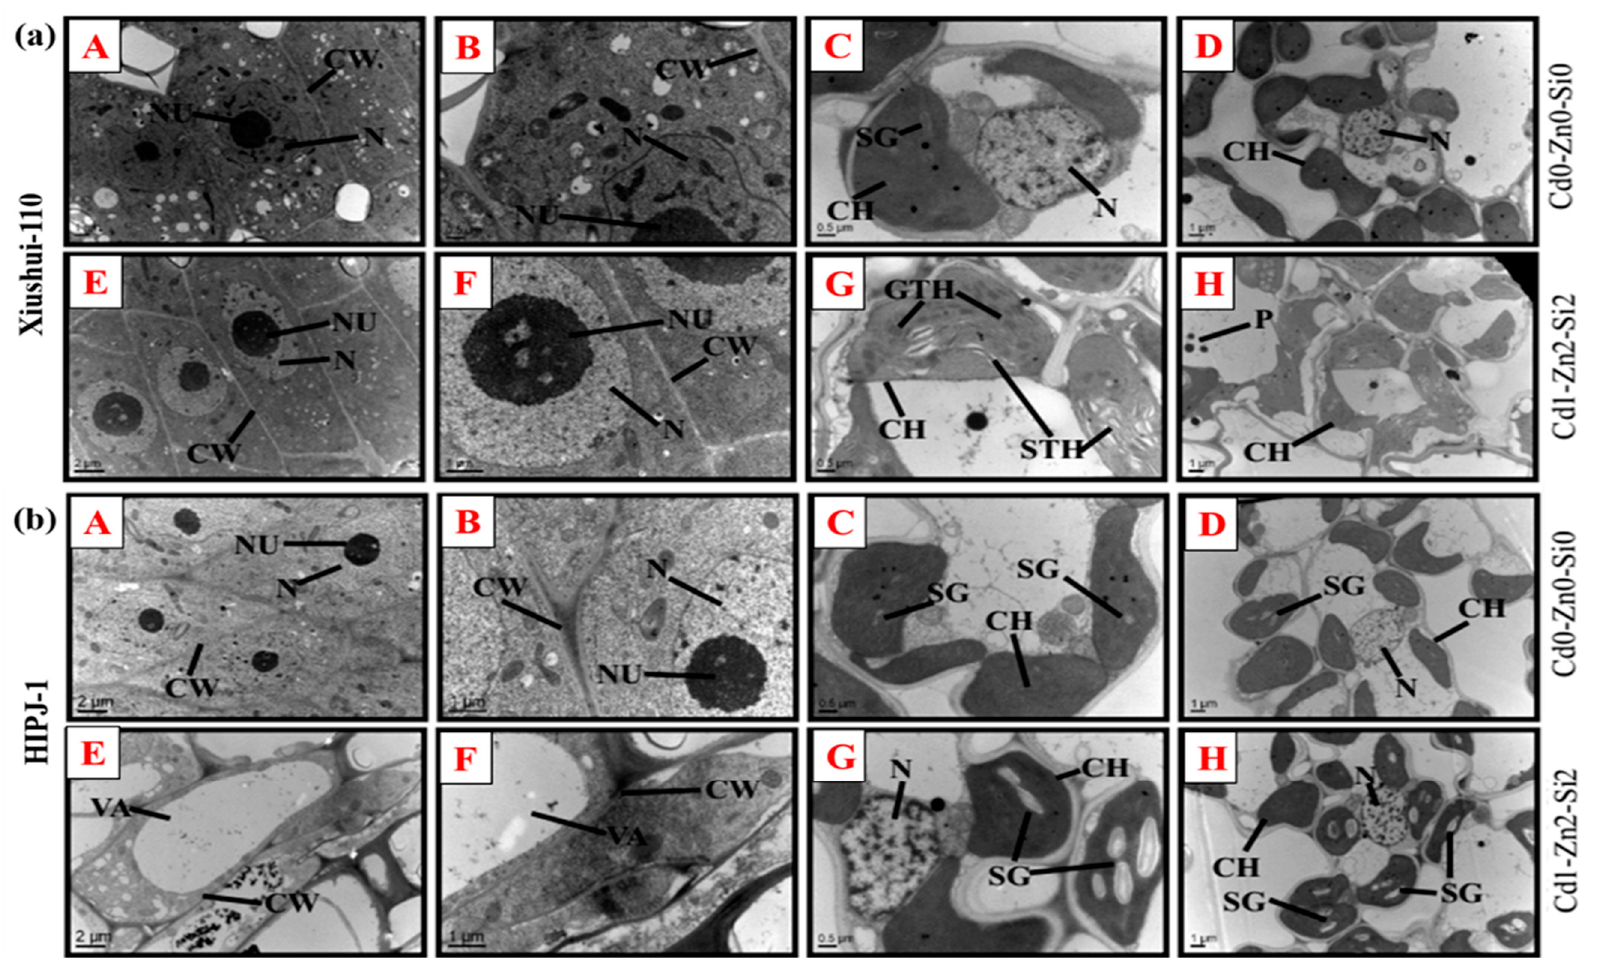
Figure 4. Ultrastructure micrograph images for ( a ) Xiushui-110 and ( b ) HIPJ-1 after 30-d treatments. Labels ( A , B ) (meristematic cells at root tip), ( C , D ) (leaf chloroplast) of control plants. Labels ( E , F ) (meristematic cells at root tip), ( G , H ) (leaf chloroplast) of treated plants Cd0 (0 µ M), Zn0 (0 µ M), Si0 (0 µ M), Cd1 (15 µ M), Zn2 (10 µ M) and Si2 (15 µ M). Legends. CH- chloroplast, STH- stromal thylakoids, GTH-granal thylakoids, SG- starch granule, P-plastoglobuli, CW-cell wall, N-nucleus, NU- Nucleolus, VA-vacuole.